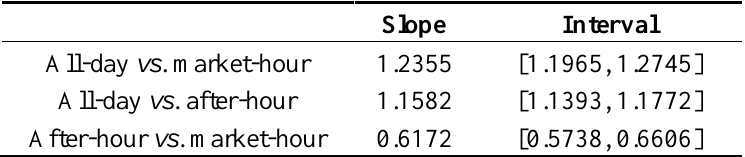
Table 4. The correlation between all-day and market-hour indicators is 0.9381. The correlation between all-day and after-hour indicators is 0.7857. The correlation between the after-hour and market-hour indicators is 0.5391.